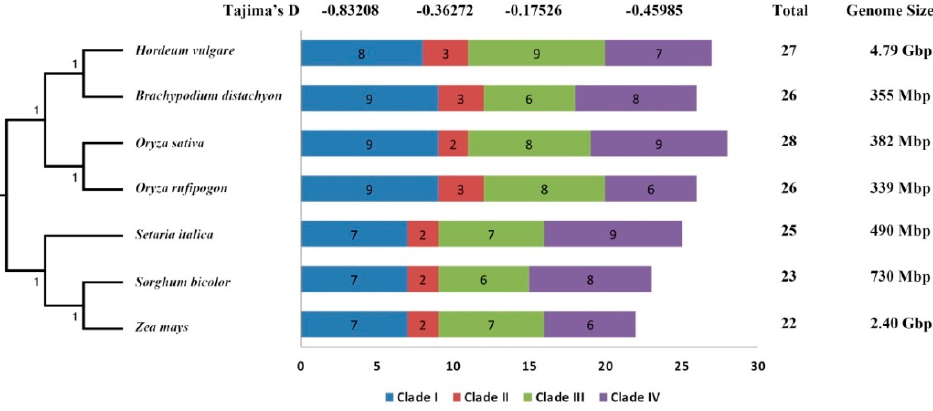
Figure 1. An NJ phylogeny tree of STP protein sequences from H. vulgare , B. distachyon , O. sativa ssp. japonica , O. rufipogon , S. italica , S. bicolor , and Z. mays . Different colors of branches represent different clades. The numbers in outside circles represent different orthologous groups (OGs), such 1 means OG1. The different species are displayed by different shaped markers. Proteins * mean unassigned STP proteins.